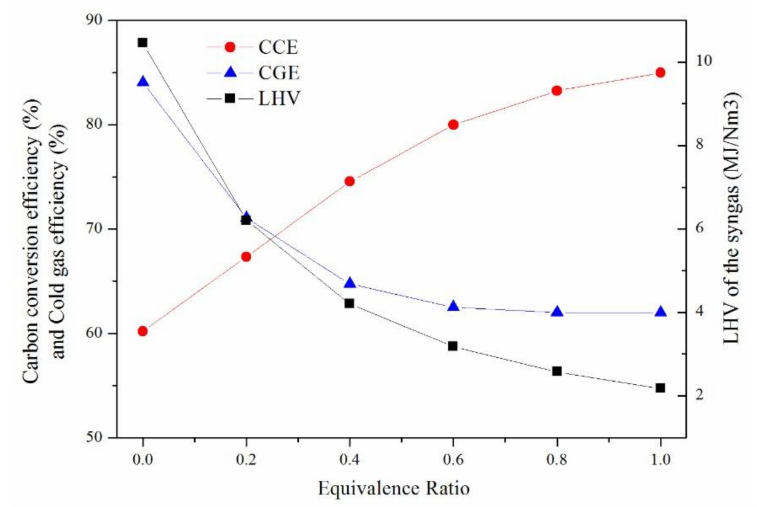
Figure 12. E ff ect of ER on CCE, CGE, and LHV (Simulation, S / C = 2, T = 700 ◦ C).